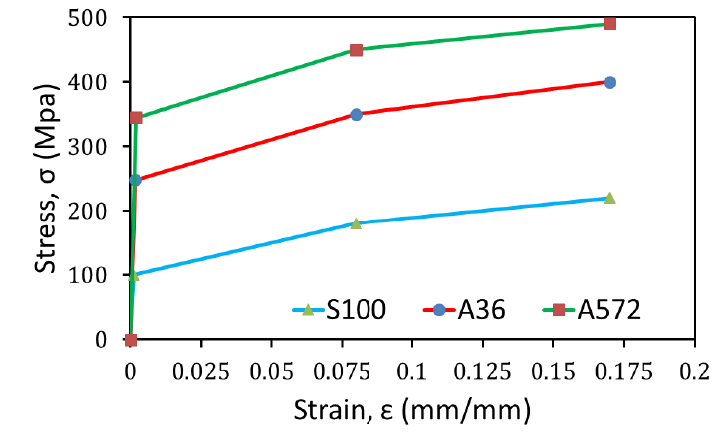
Fig. 2 . Material properties of steel.